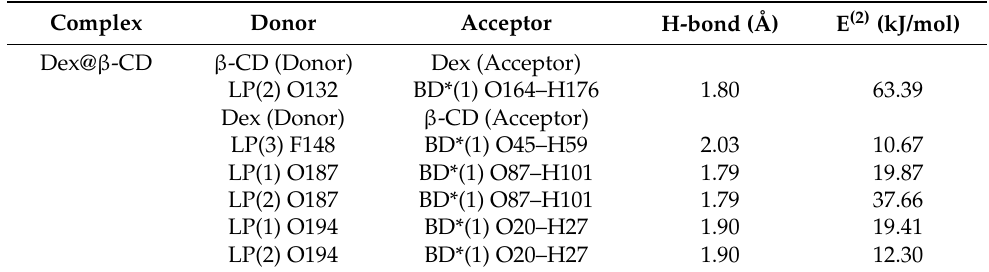
Table 2. NBO analysis of hydrogen-bonding interactions and stabilization energies E (2) (kJ/mol) for the Dex@ β -CD